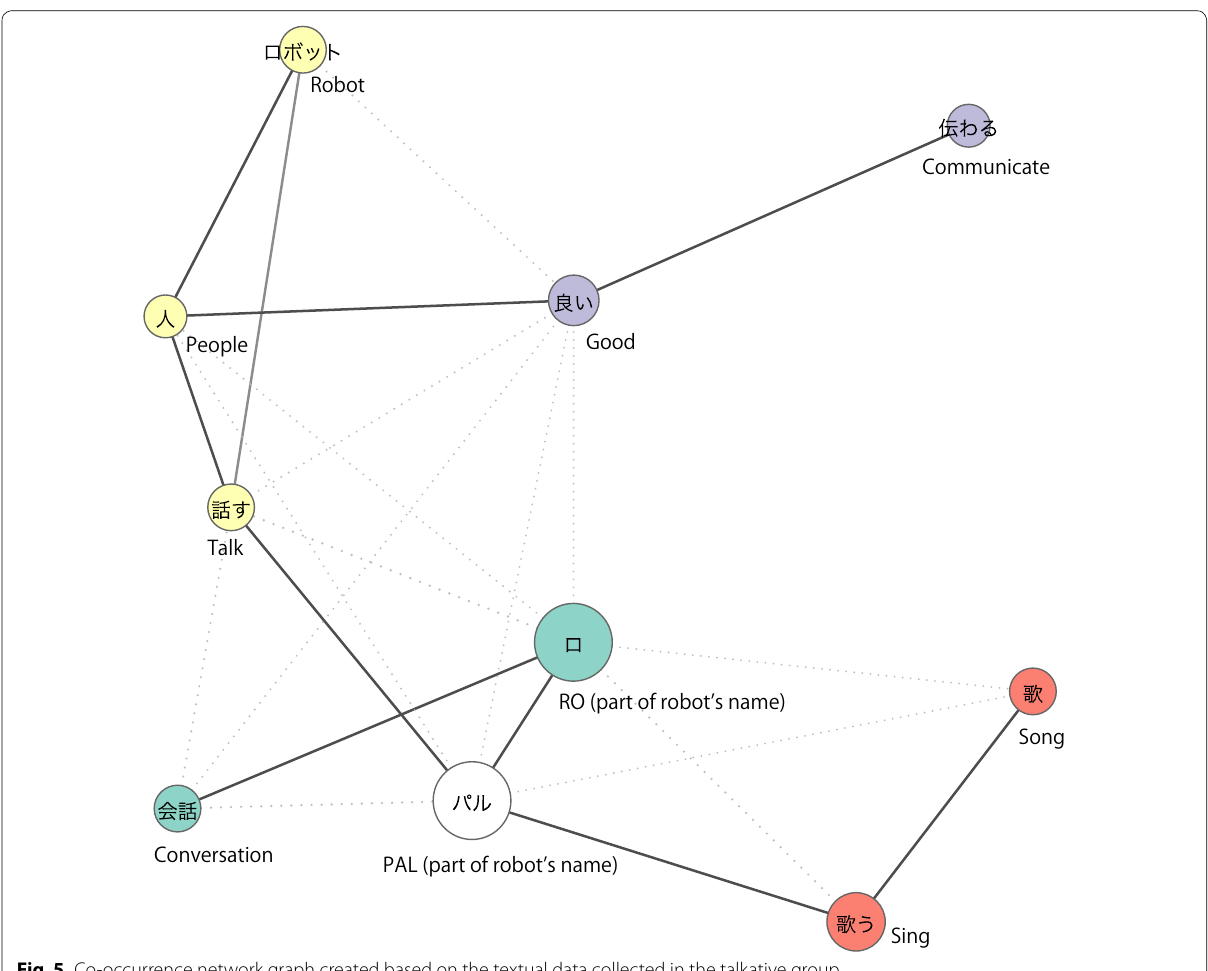
Fig. 5 Co-occurrence network graph created based on the textual data collected in the talkative